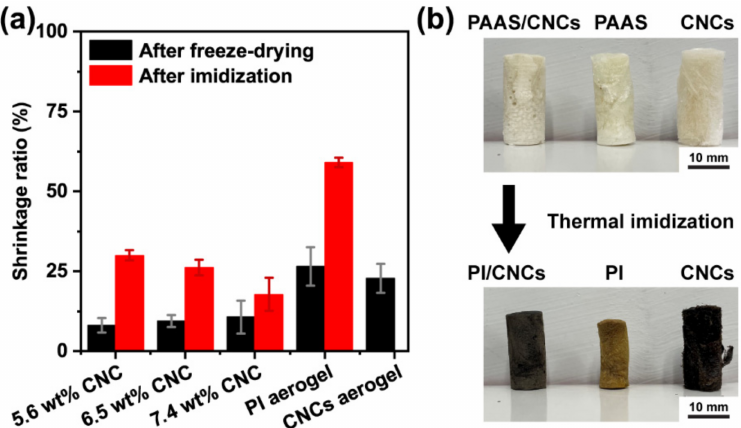
Figure 6. ( a ) Volumetric shrinkage ratio of aerogels after freeze-drying and after thermal imidization. ( b ) The appearance of aerogels before and after thermal